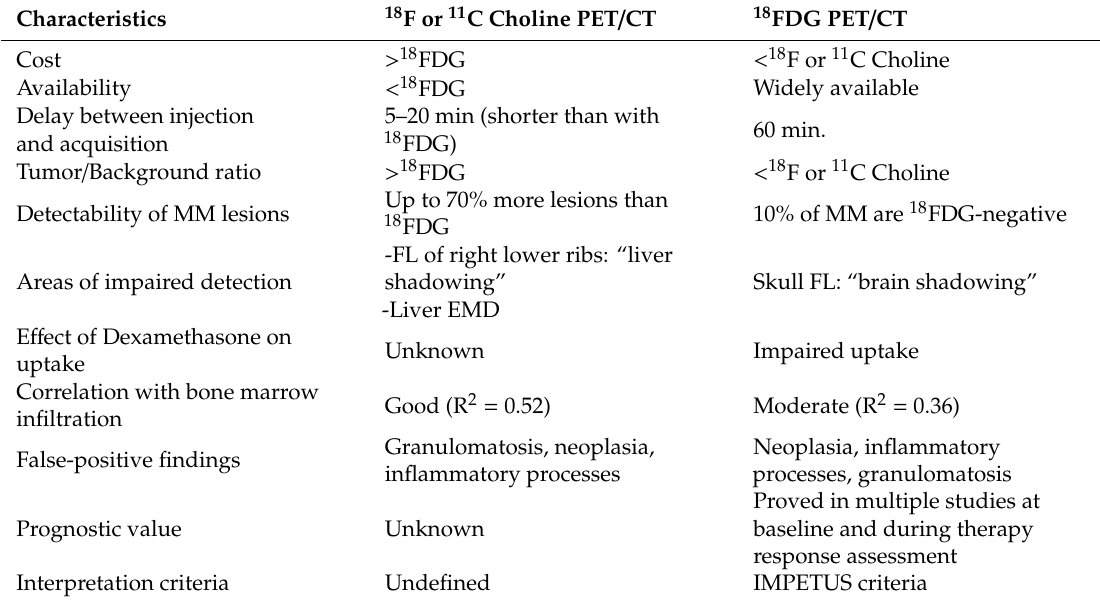
Table 2. Comparative table of the main characteristics of 18 F-Choline or 11 C-Choline PET / CT vs. 18 FDG PET / CT in multiple